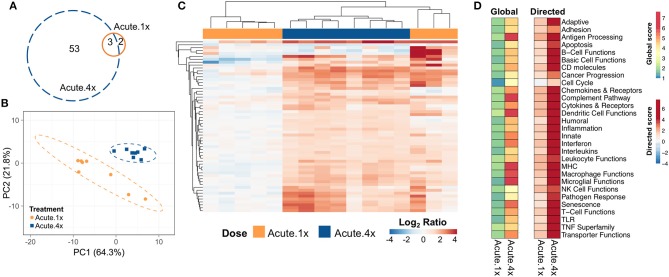
Acute transcriptional response of immune-associated genes in lung tissues of mice that received either a single or four weekly instillations of cSiO2. Mice received a single dose (Acute.1x) or four repeated weekly doses (Acute.4x) of cSiO2 via intranasal instillation, and gene expression was determined in lung tissues obtained 1 day after the last dose. (A) Venn diagram depicting the number of genes identified as differentially expressed in lung tissue of mice that received a single cSiO2 instillation (orange line) or four weekly cSiO2 doses (blue dashed line) as compared to dosing-matched vehicle controls. (B) Principal components analysis of differentially expressed genes (BH q < 0.05, log2 ratio >1 or < −1) in lung tissues of mice exposed to cSiO2 once or four times compared to dosing-matched vehicle controls. PC1 and PC2 are shown with the 95% confidence interval bands (dashed ellipses). (C) Unsupervised, bidirectional hierarchical cluster analysis of lung immune pathway transcriptome data using the Euclidean distance method with average linkage. All genes differentially expressed in either the Acute.1x (orange) or Acute.4x (blue) treatment groups were included in the heatmap, which is colored by the log2 ratio of transcript counts calculated with respect to average expression in dosing-matched vehicle controls. (D) Heatmaps depicting either global or directed significance scores for immune-related pathways (see Materials and Methods for details on calculation of significance scores).